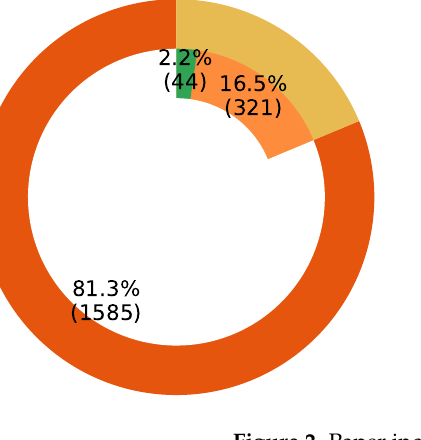
Figure 2. Paper inclusion